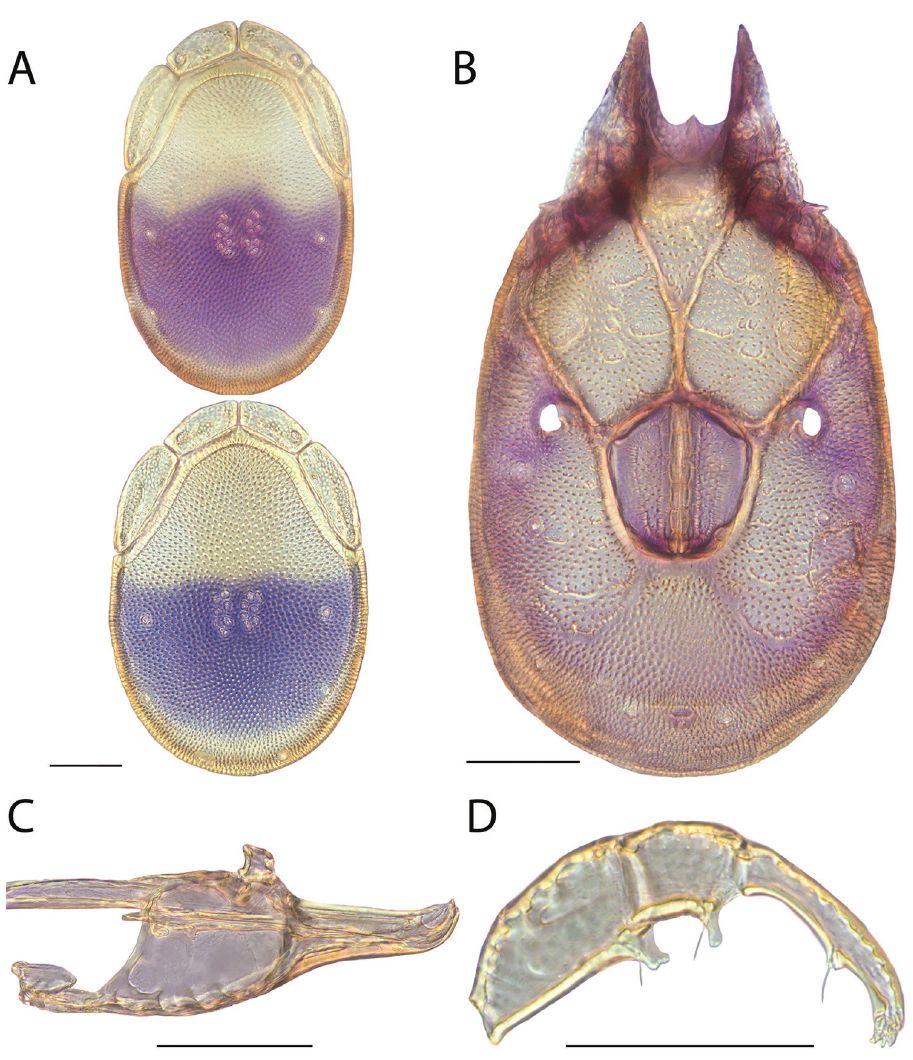
Figure 165. Torrenticola nigroalba female: A dorsal plates, note variation B venter (legs removed) C sub- capitulum D pedipalp (setae not accurately depicted). Scale = 100